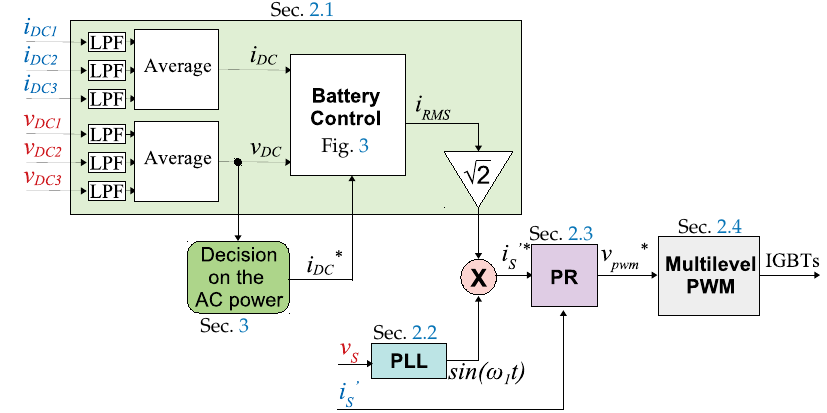
Figure 1. Overview of the control of the developed equipment.